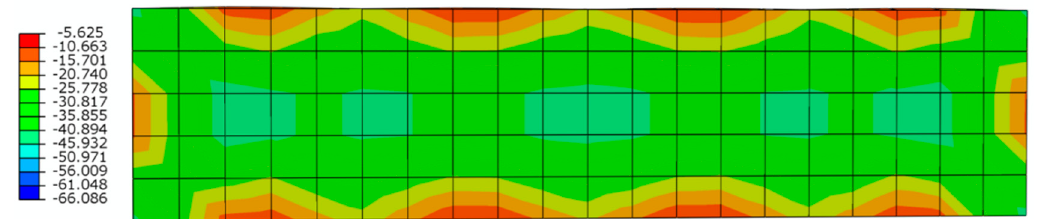
Energies 2019 , 12 , x Figure 16. Stress distribution of concrete under peak load (MPa). Figure 16. Stress distribution of concrete under peak load (MPa).